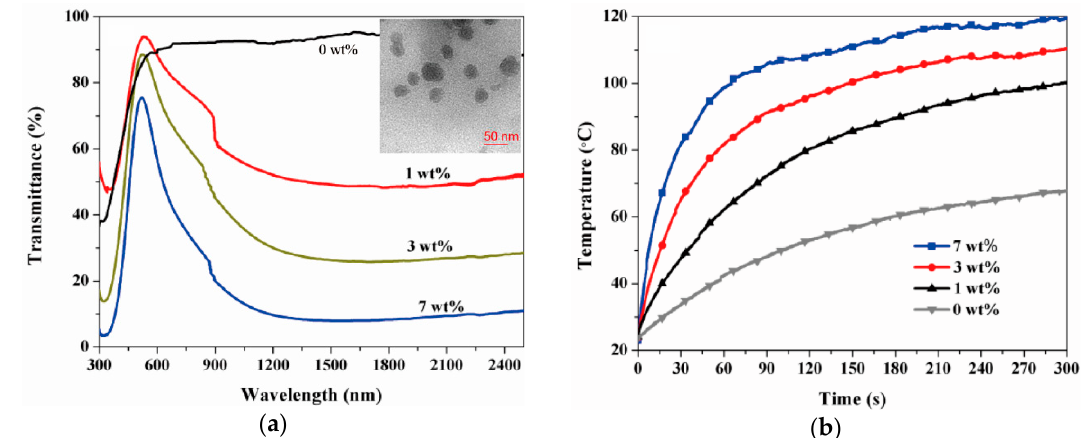
Figure 2. ( a ) UV-vis-NIR transmittance spectra of WO 2.72 / polyurethane (PU) nanocomposites prepared with different weight fractions of WO 2.72 (0–7 wt %) with an inserted image of cross-sectional high-resolution transmission electron microscopy (HR-TEM) at 7 wt % and ( b ) corresponding photothermal temperature distribution at the different weight factions. Reproduced from Ref. [82].